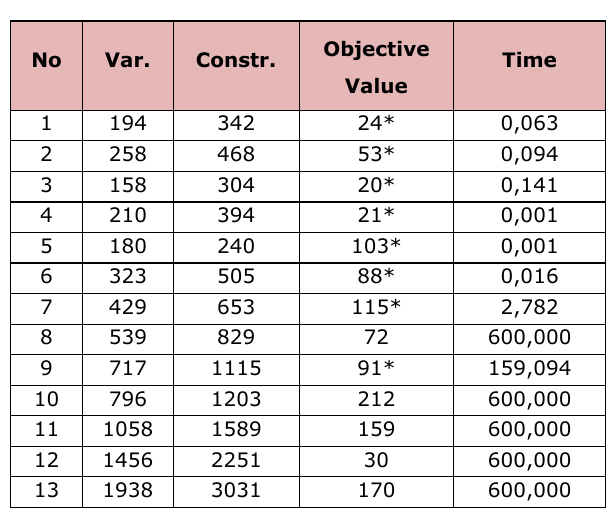
Table 3. “Obtained results by the assignment model”. Source: